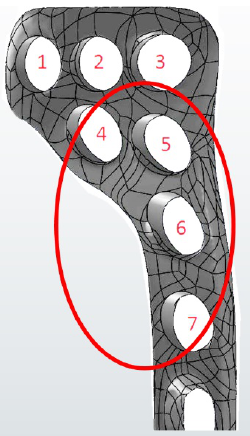
Figure 5. CAD model of the superior part of the plate and numbering of the screw holes.